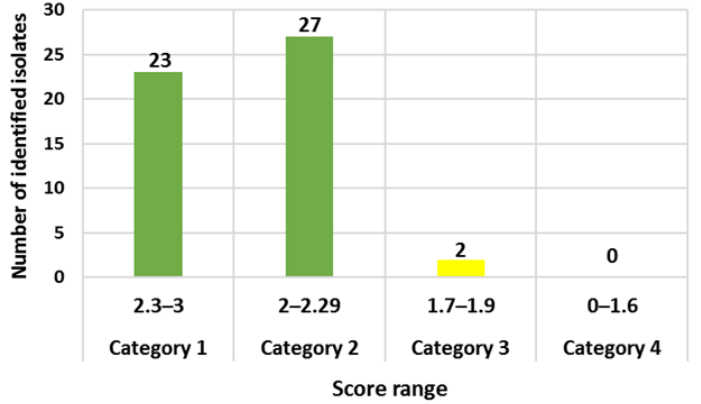
Fig. 2. Score values of 52 E. faecalis strains identified by Microflex Table 3. Distribution of recovered DFIs bacteria in relation to age groups Age Group